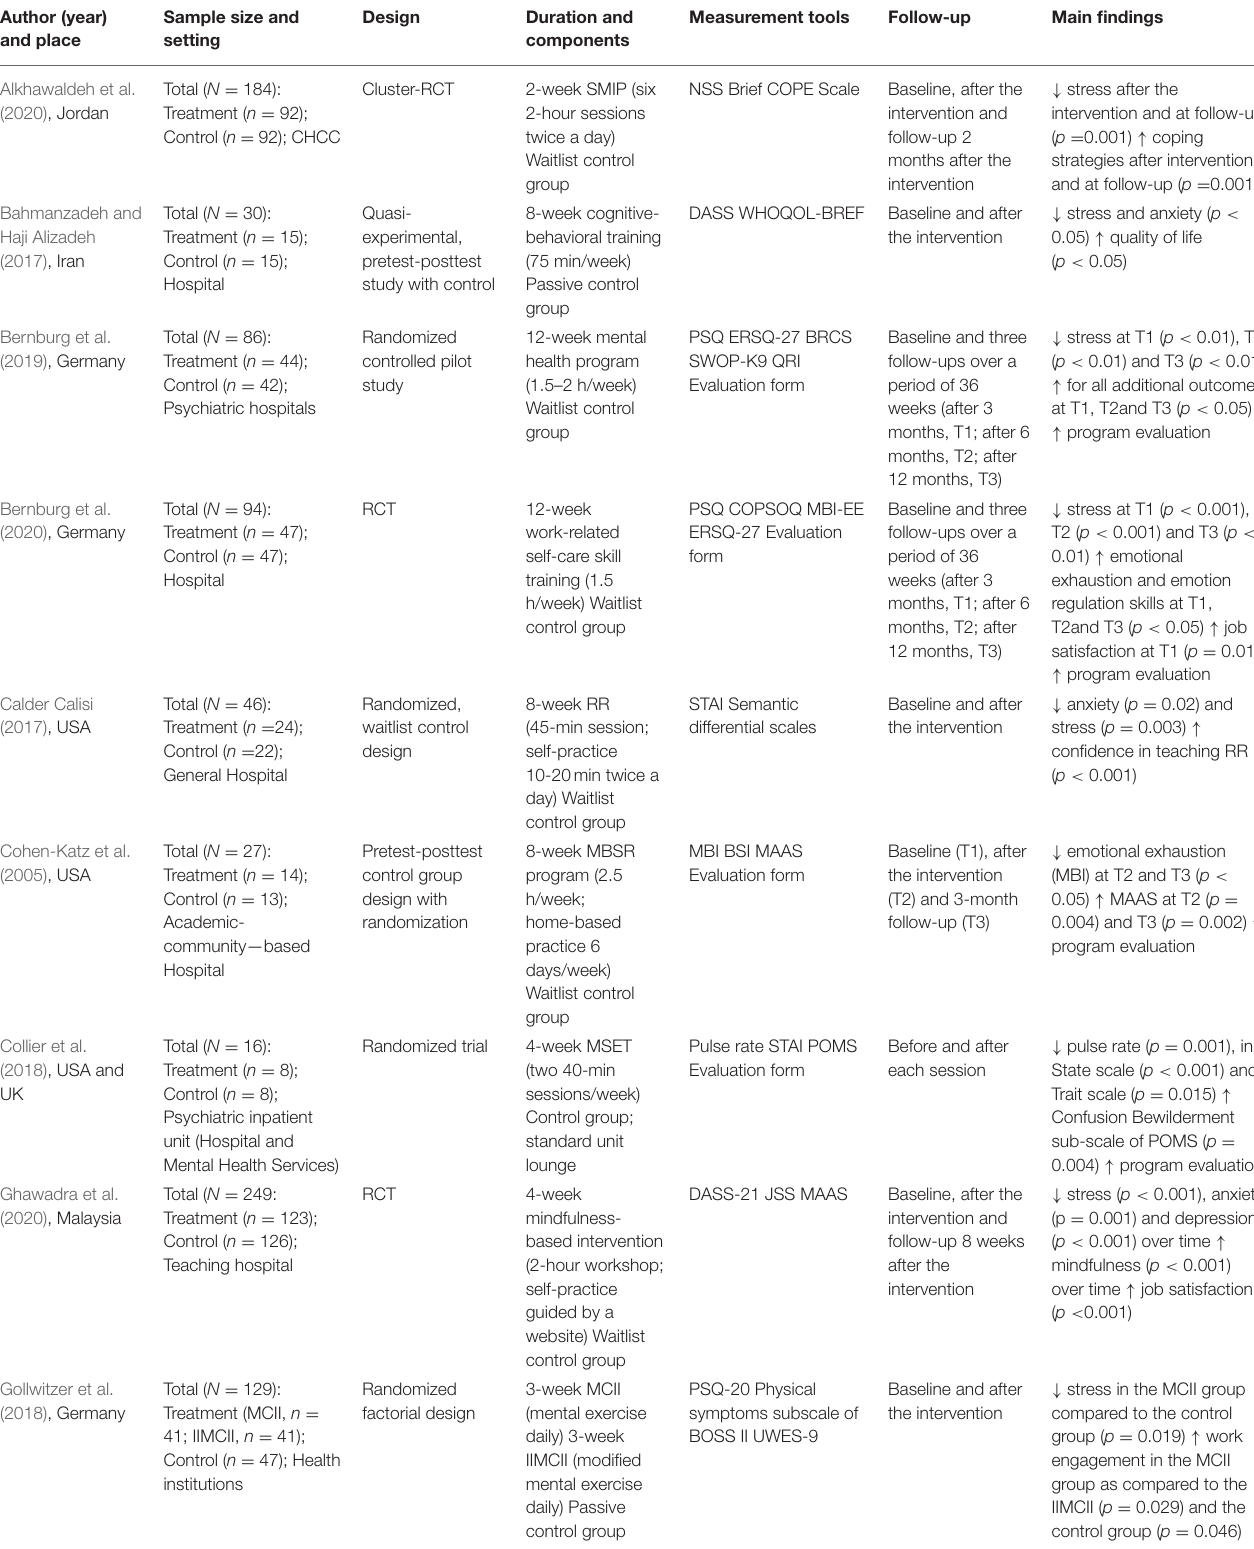
TABLE 1 | Summary of articles included in the current literature